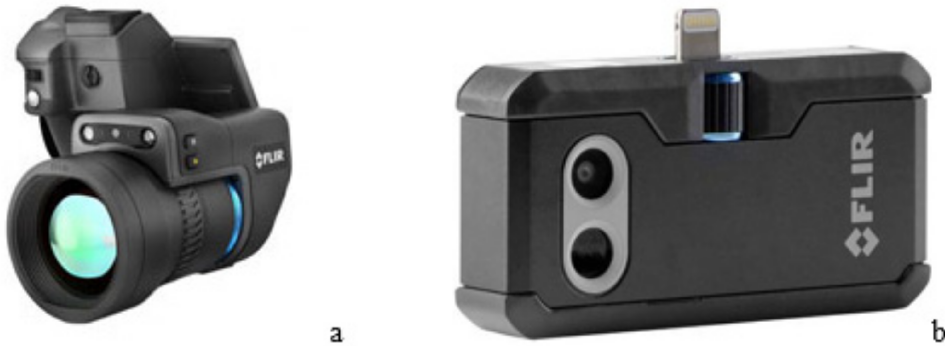
Figure 3. The two thermal cameras chosen for diabetic foot ulcer detection. ( a ) The FLIR T1030SC camera chosen for the PRO edition and ( b ) the lower priced FLIR ONE PRO chosen for the in-home